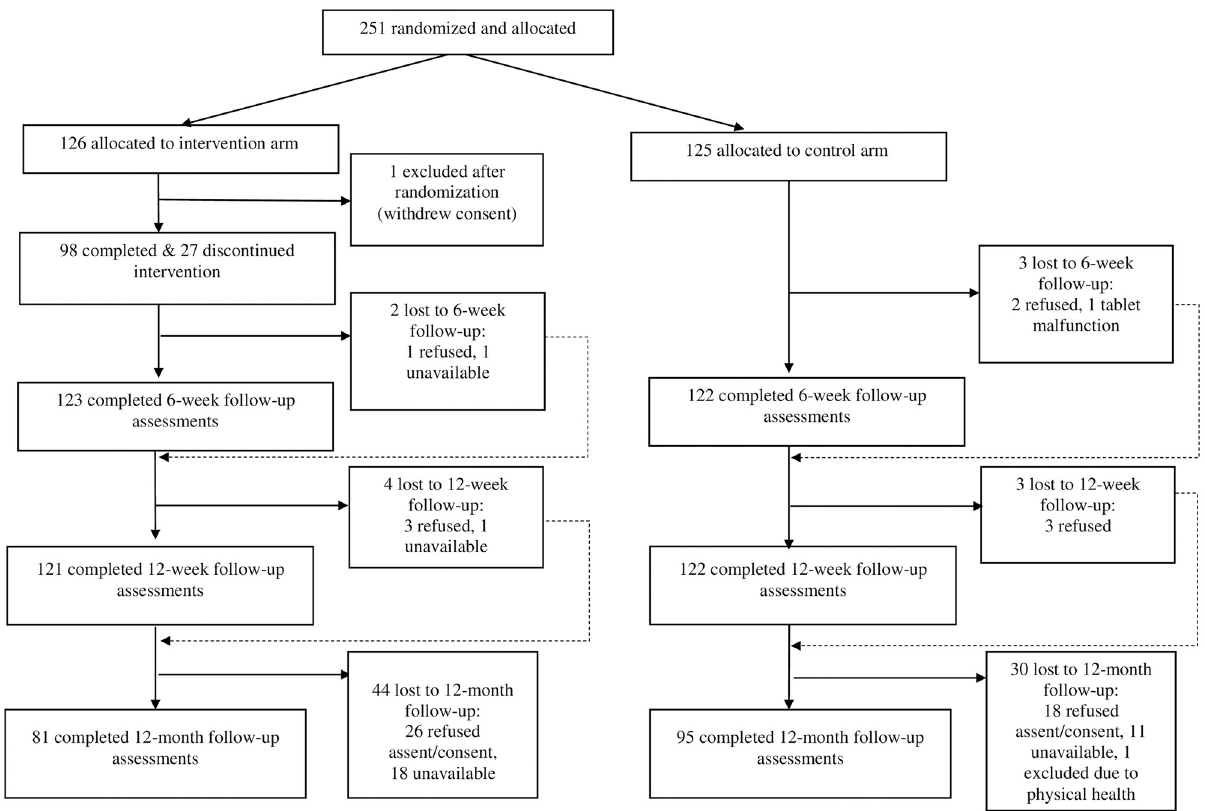
Fig 1. CONSORT diagram for trial participants. CONSORT, Consolidated Standards of Reporting